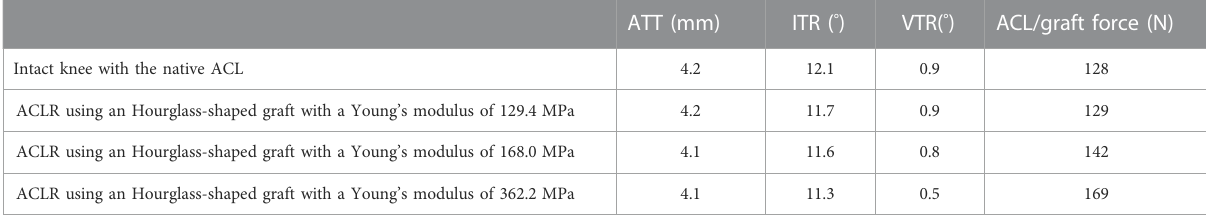
TABLE 3 ATT, Anterior tibial translation; IRT, internal tibial rotation; VTR, valgus tibial rotation and ACL/graft force in the intact knee and knee after ACLR using an hourglass-shaped graft with different elasticity.